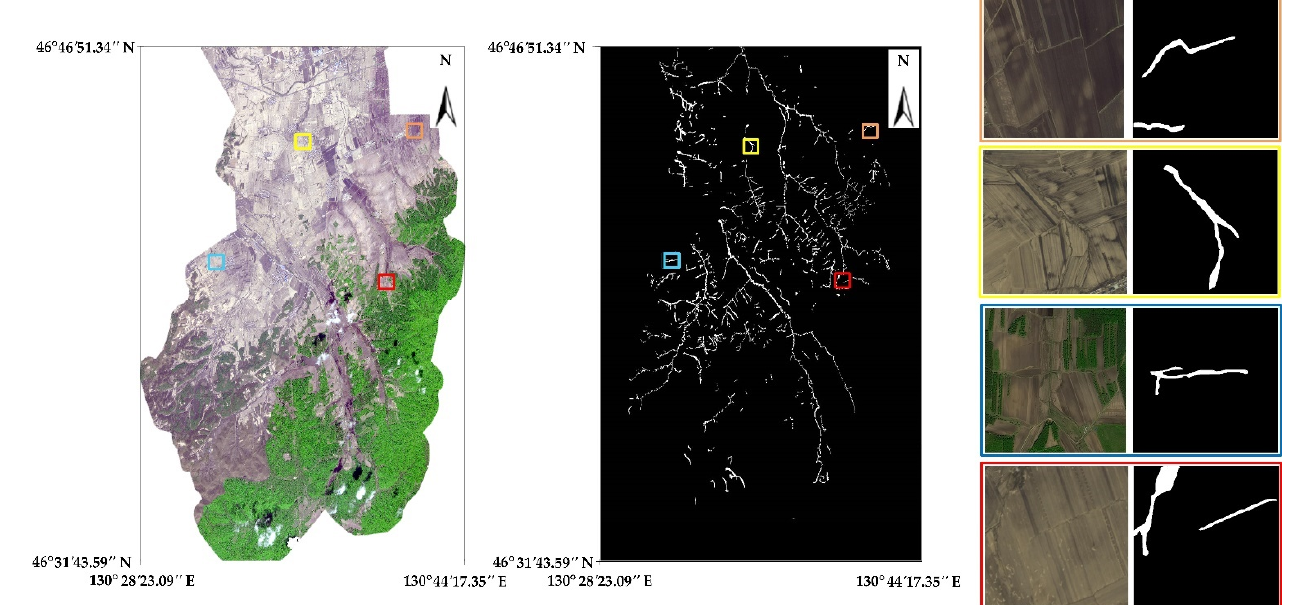
Figure 9. The latest monitoring data of Experiment 2 and corresponding labels. Among them, the colored rectangles are the representative lands, and the white as well as black pixels in the labels separately represent gully erosion and non-gully erosion.